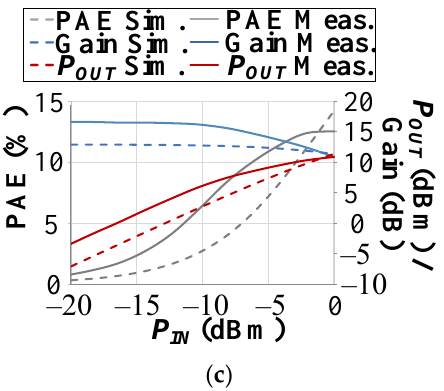
Figure 13. Large-signal post-layout PEX simulation vs. CW measurement of the broadband CMOS FD-SOI PA at ( a ) 24, ( b ) 28, and ( c ) 44 GHz. Figure 14 plots the measured maximum PAE, S 21 , and P OUT,SAT vs. the frequency from 20–44 GHz, which shows this PA maintains a maximum PAE ≥ 12.5% and P OUT,SAT ≥ 11 dBm across this frequency range. It achieves a maximum PAE ≥ 15.1% and P OUT,SAT ≥ 12.9 dBm across 24–39 GHz, highlighting the broadband performance of this CMOS PA.